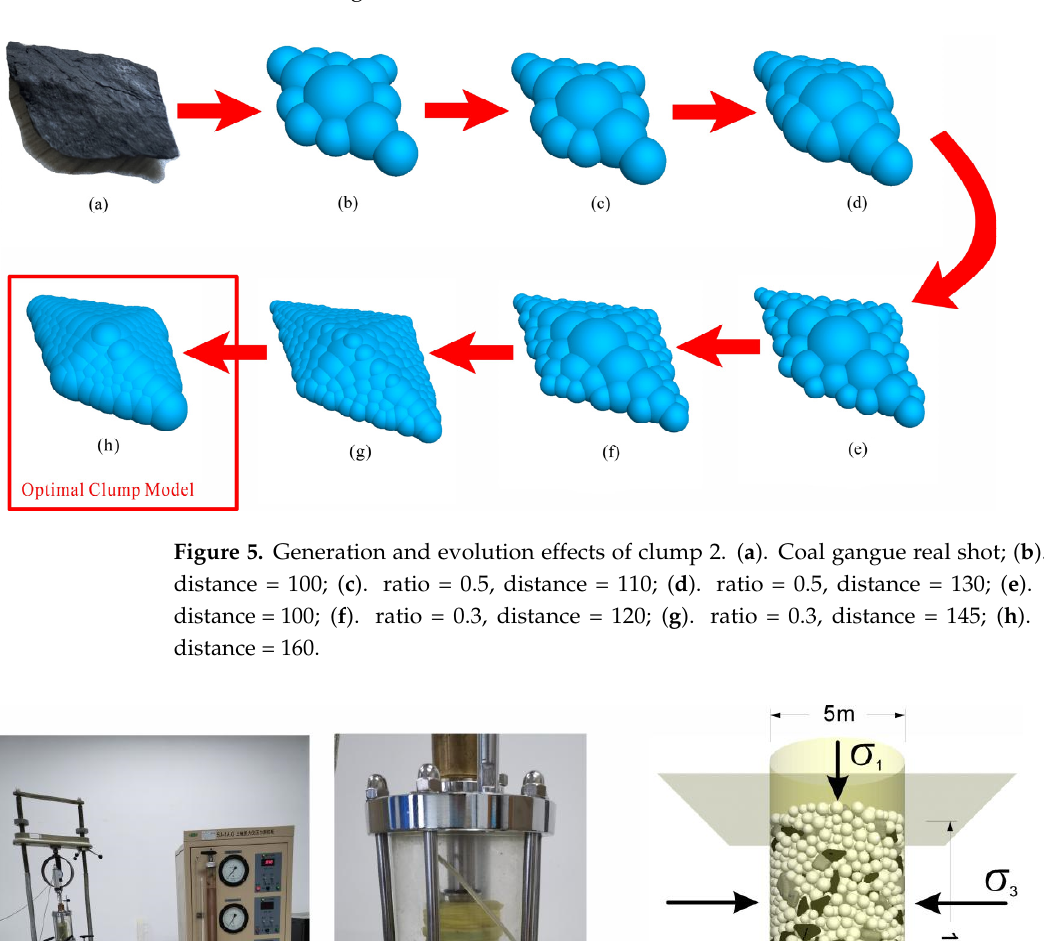
Figure 5. Generation and evolution effects of clump 2. ( a ). Coal gangue real shot; ( b ). ratio = 0.5, distance = 100; ( c ). ratio = 0.5, distance = 110; ( d ). ratio = 0.5, distance = 130; ( e ). ratio = 0.3, distance = 100; ( f ). ratio = 0.3, distance = 120; ( g ). ratio = 0.3, distance = 145; ( h ). ratio = 0.5,distance = 160.